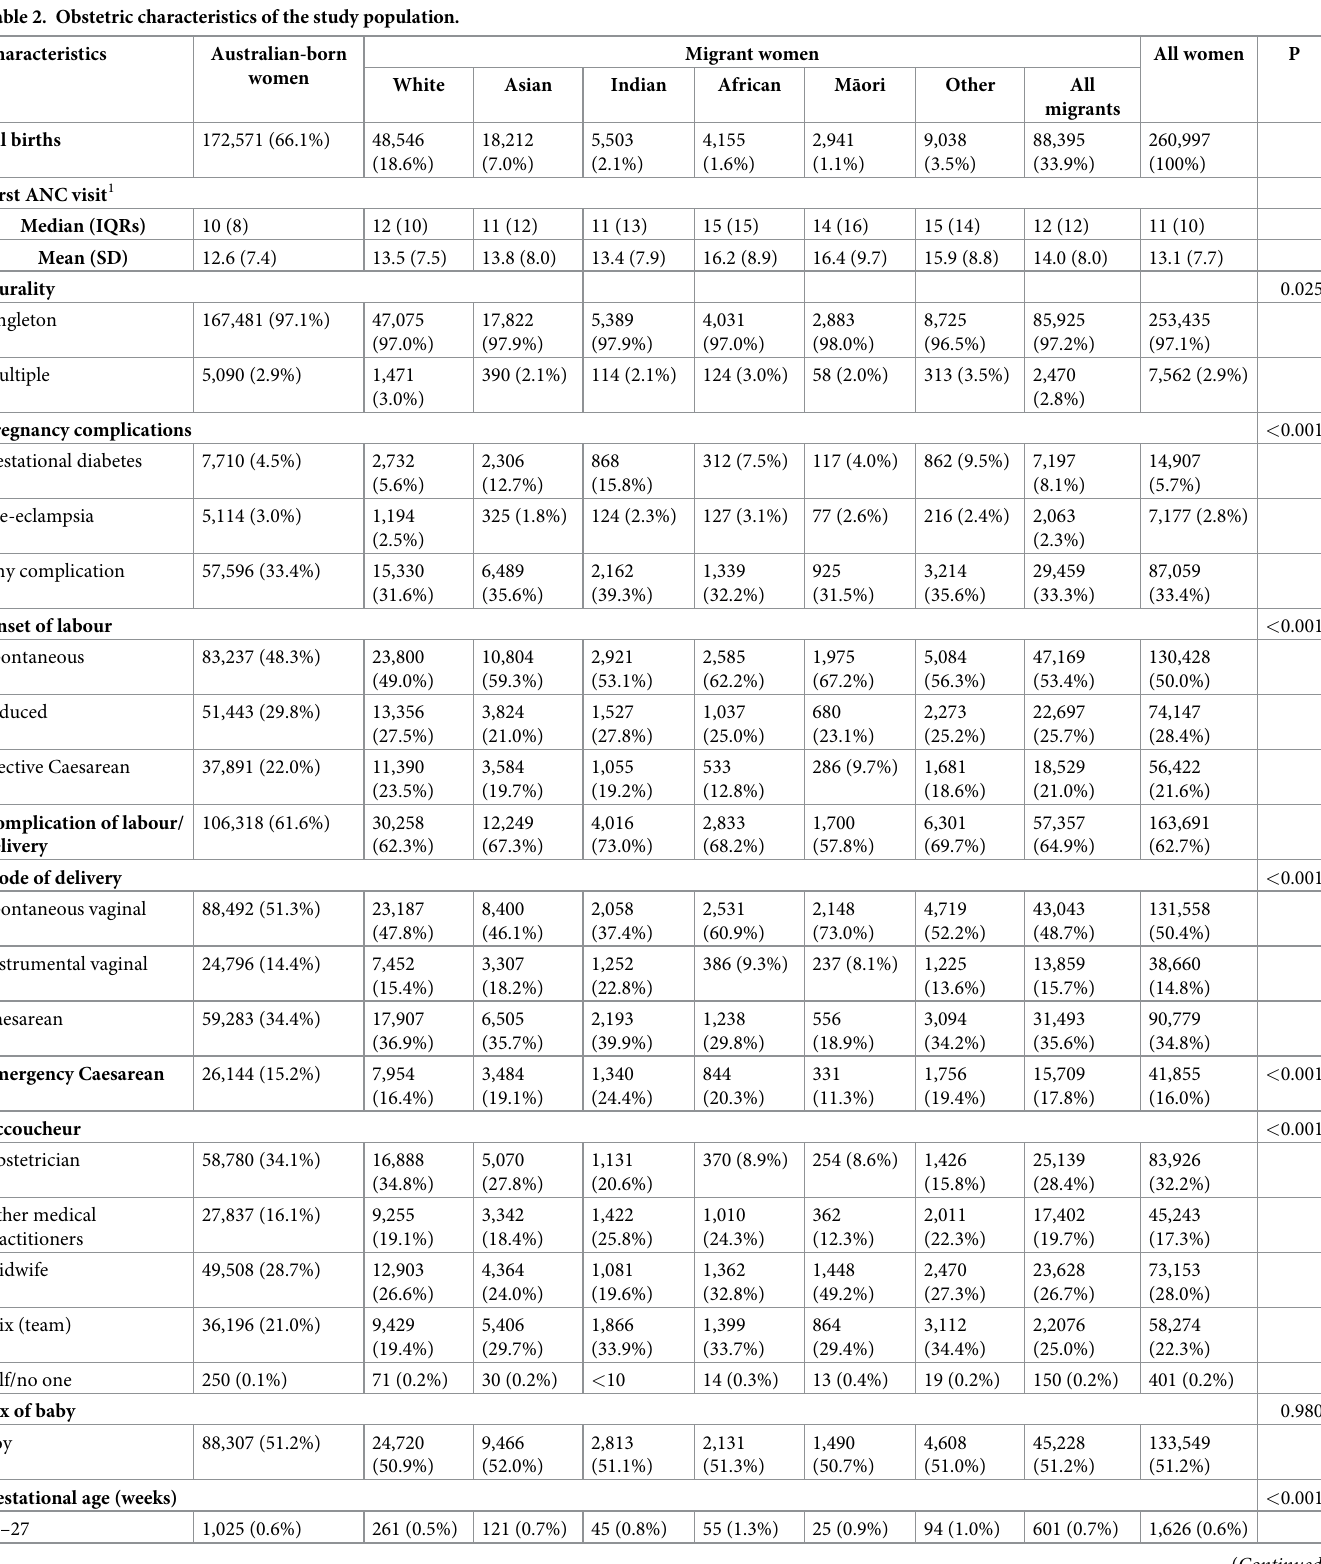
Table 2. Obstetric characteristics of the study population.